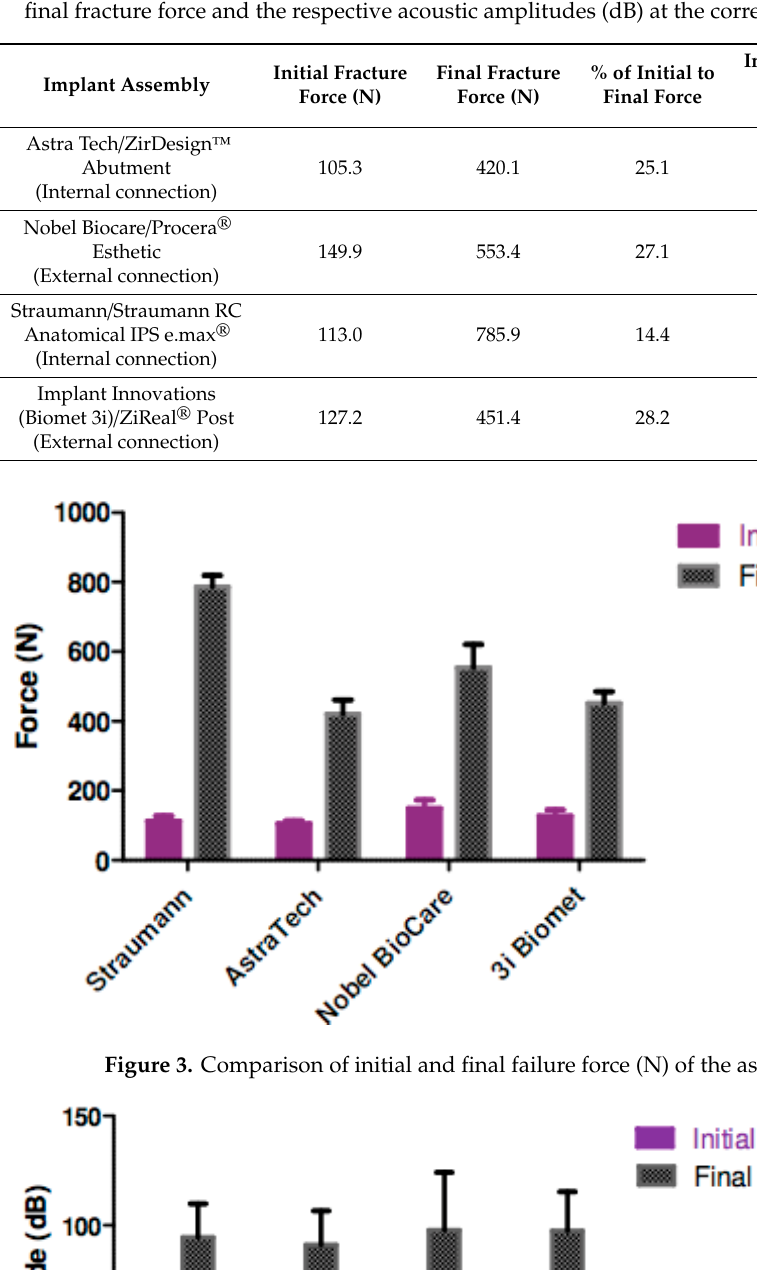
Table 2. Means of the initial and final fracture force (N), percentage of the initial fracture force to its final fracture force and the respective acoustic amplitudes (dB) at the corresponding fractures.